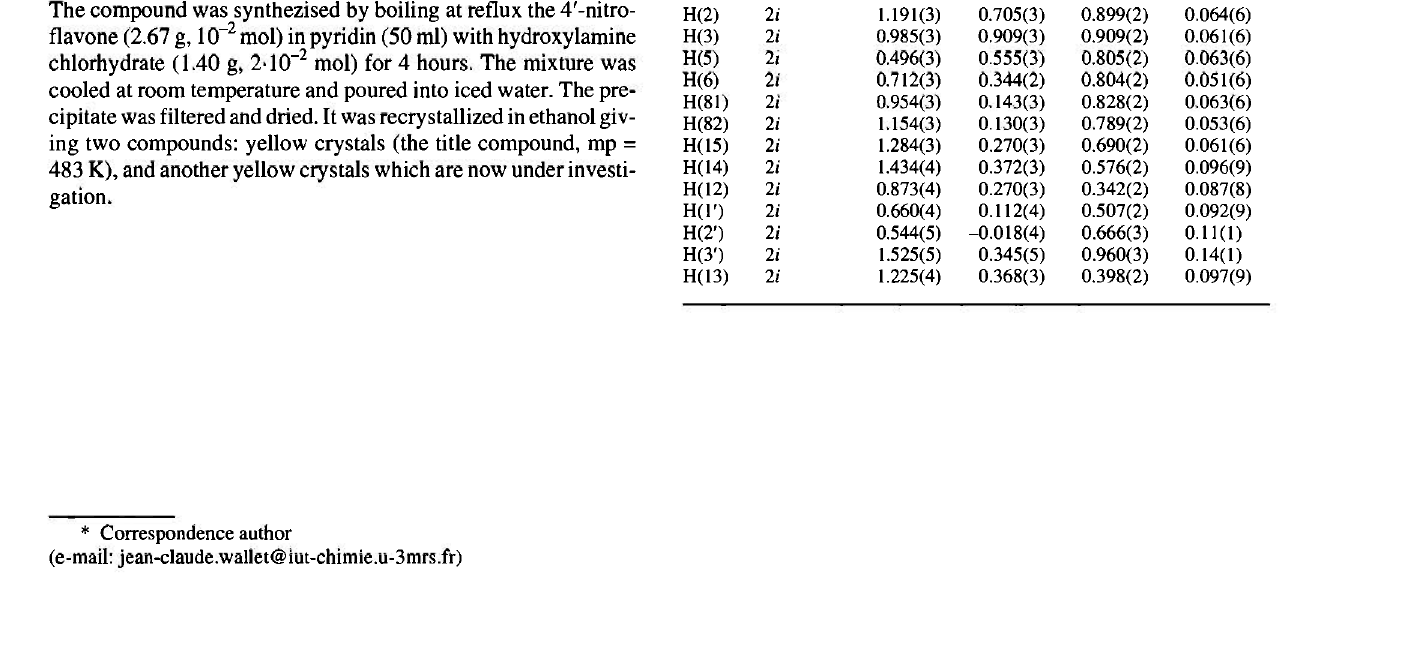
Table 2. Atomic coordinates and displacement parameters (in Ä 2